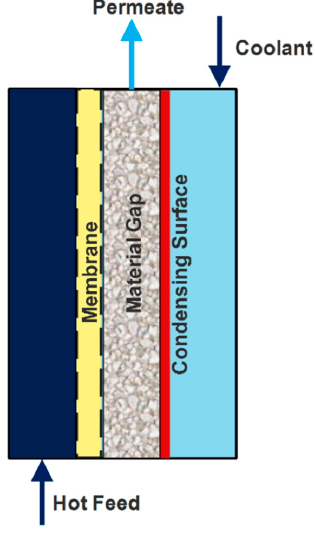
Figure 7. Schematic diagram of material gap membrane distillation (MGMD) [83] .